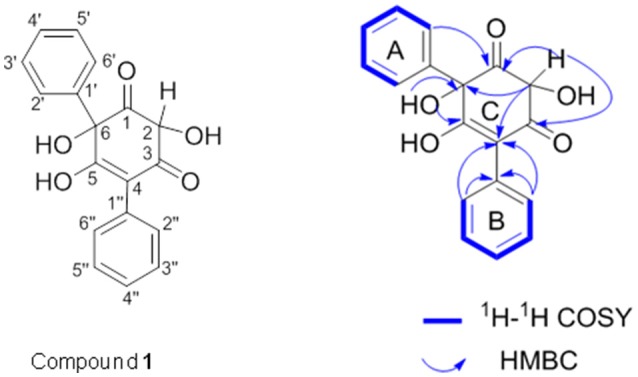
1H−1H COSY (blue bold lines) and key HMBC (blue arrows) correlations of compound 1. COSY is two-dimensional spectrum which is used to identify spins coupled to each other, and HMBC is two-dimensional inverse H,C correlation technique that allow for the determination of carbon to hydrogen connectivity.